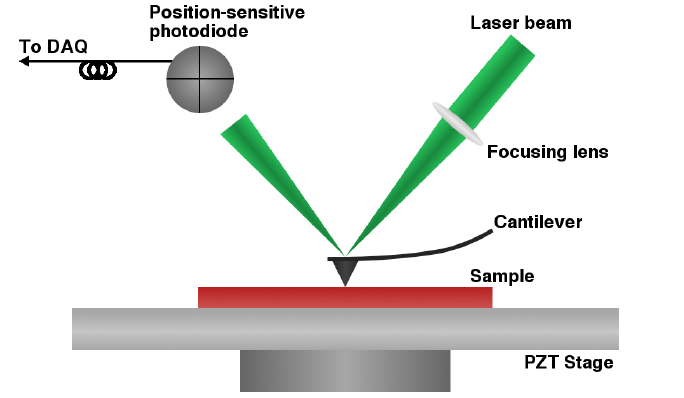
Figure 9. AFM equipment utilizes a laser beam deflected off the rear face of a microscopic cantilever to measure the tip deflections resultant from intermolecular forces acting on the nano-scale tip using a position-sensitive photodiode and Data Acquisition unit